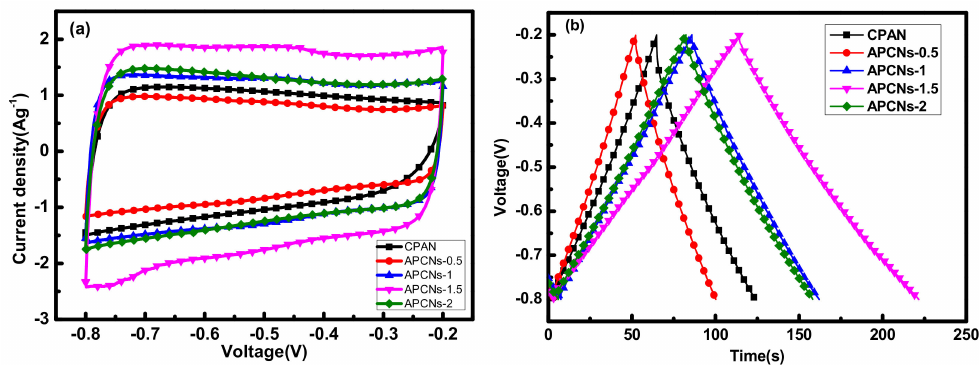
Figure 12. Electrochemical properties of each sample in KOH electrolyte: ( a ) a curve with a scan rate of 10 mV s − 1 CV; ( b ) a constant current charge and discharge with a current density of 1 A g − 1